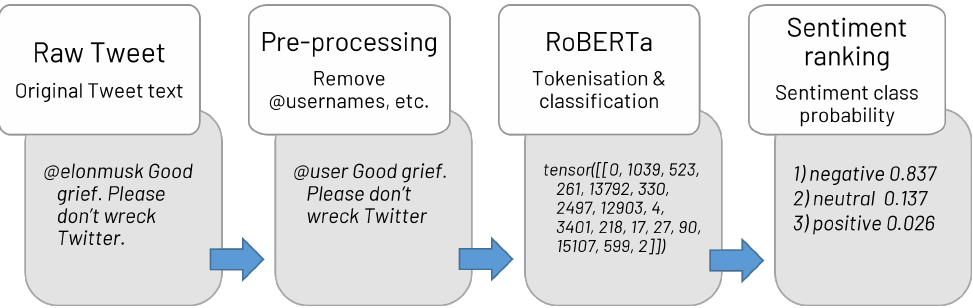
Figure 1. Workflow of sentiment analysis with example